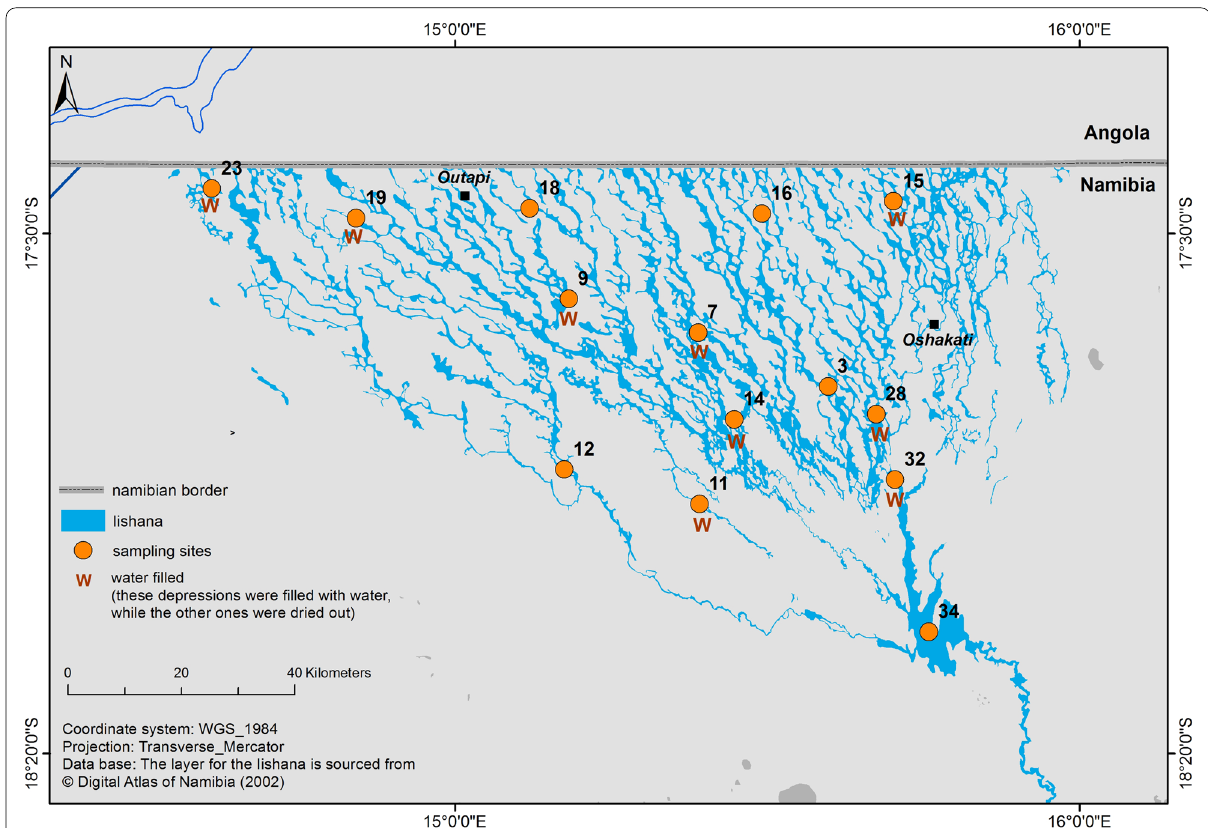
Fig. 3 The focus region of the Iishana system with sampling sites, indicating whether the Iishana were carrying water at the time of